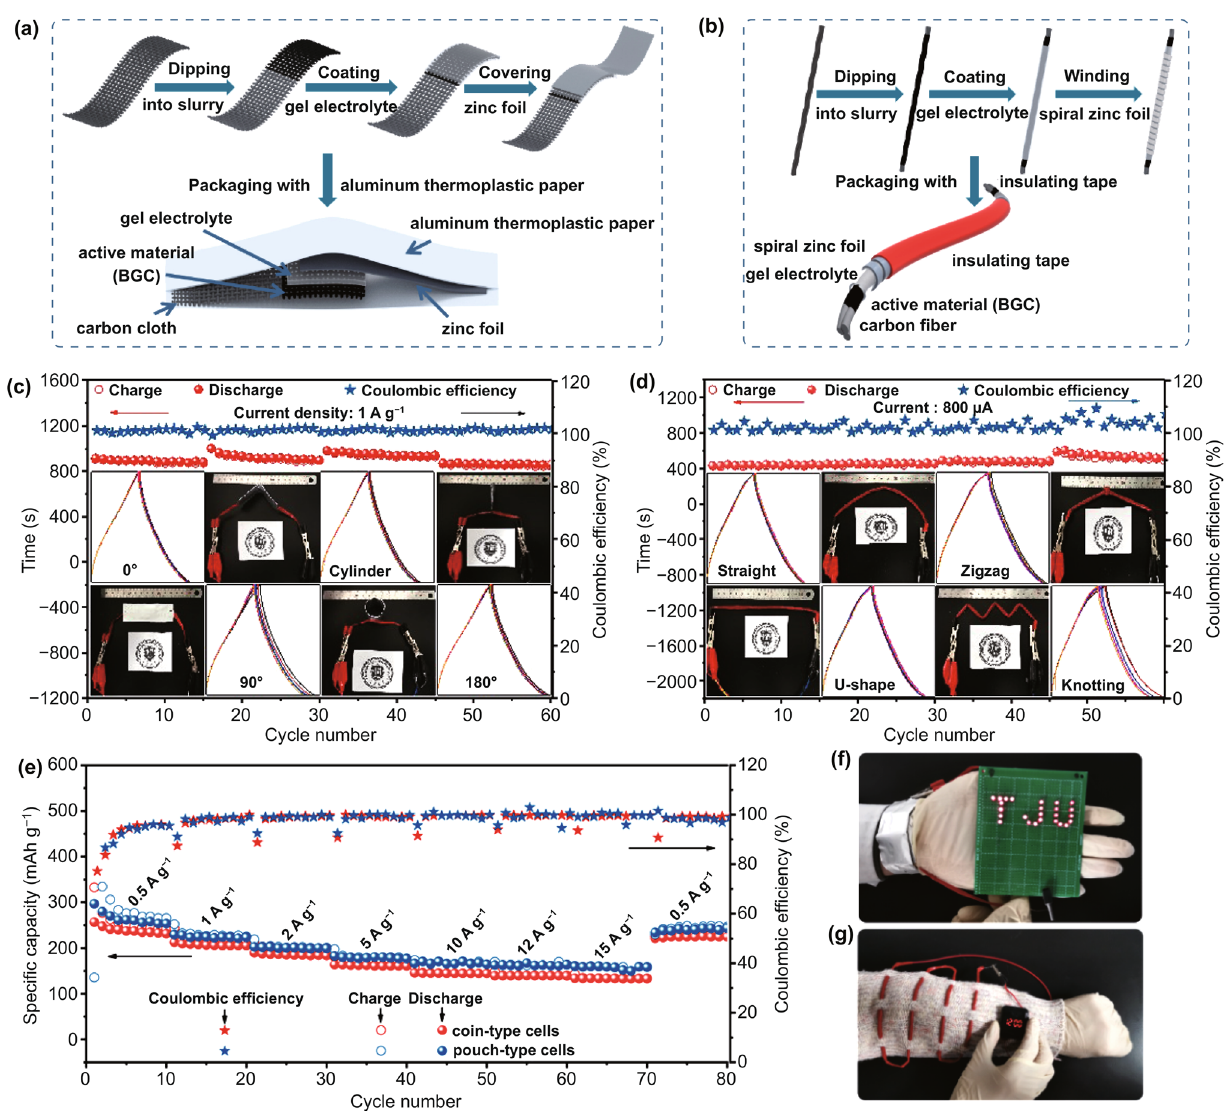
Fig. 5 a , b Schematic diagrams of pouch-type and cable-type quasi-solid-state zinc ion capacitors. Cycling performance of pouch-type cell c and cable-type cell d upon deformation. The inserts exhibit the optical images of the deformed cells and corresponding galvanostatic charge–dis- charge profiles. e Specific capacities at various current densities for coin cells and pouch-type cells. f Photograph of LED array powered by two pouch-type cells in series. g Photograph of a digital watch powered by four cable-type cells in